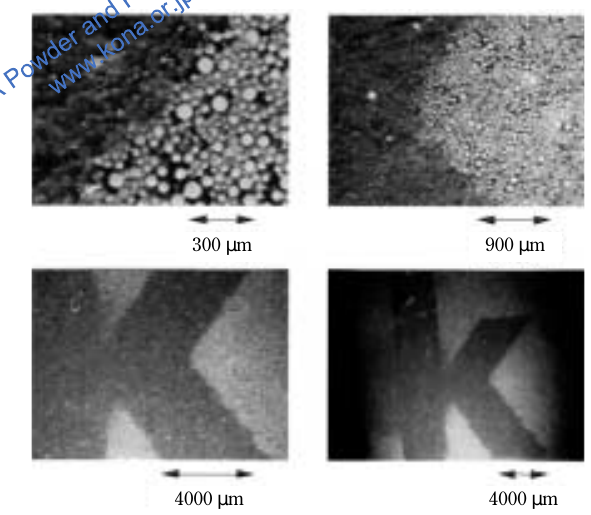
Fig. 5 Photograph of first commercial display with elec- trophoretic ink by E-ink’s Immedia Technology in J.C. Penney stores